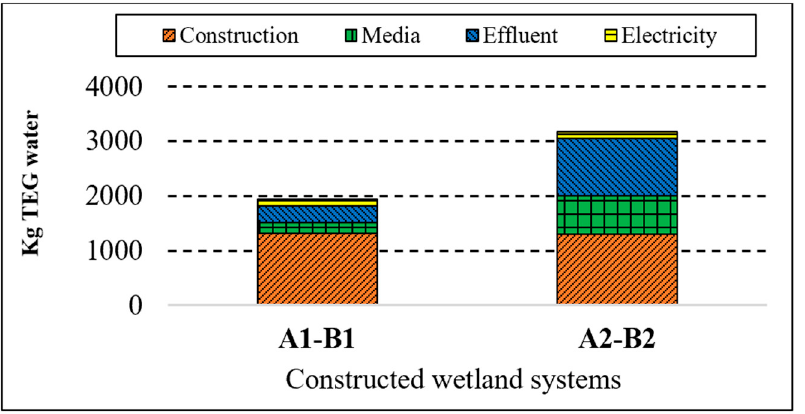
Figure 6. Impact assessment on aquatic ecotoxicity for two different CW systems.